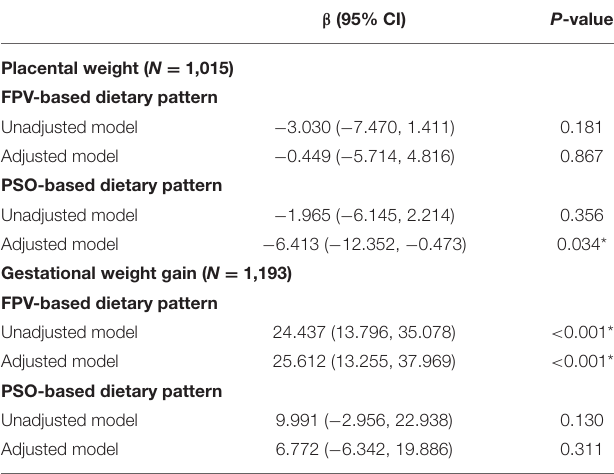
TABLE 5 | Linear regression analyses of dietary pattern scores and infant